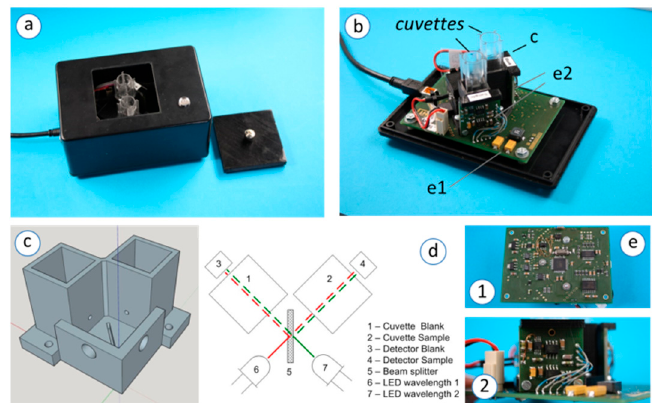
Figure 1. 2-light emitting diode (LED)-µSpectrophotometer for colorimetric real-time loop-mediated isothermal amplification (LAMP) assay. ( a ) Instrument in enclosure. ( b ) On the main board (e1) with the electronic control, a holder for two cuvettes (sample as well as blank) is positioned. A detector is also attached to each of the holders on a smaller board (e2). ( c ) Drawing of the cuvette holder, which is 3D-printed. ( d ) Optical setup with two LEDs of different wavelength, the beam splitter, the cuvettes (inside their holder), and the respective detectors. ( e ) Electronic mainboard (e1) as well as the two detector boards (e2).